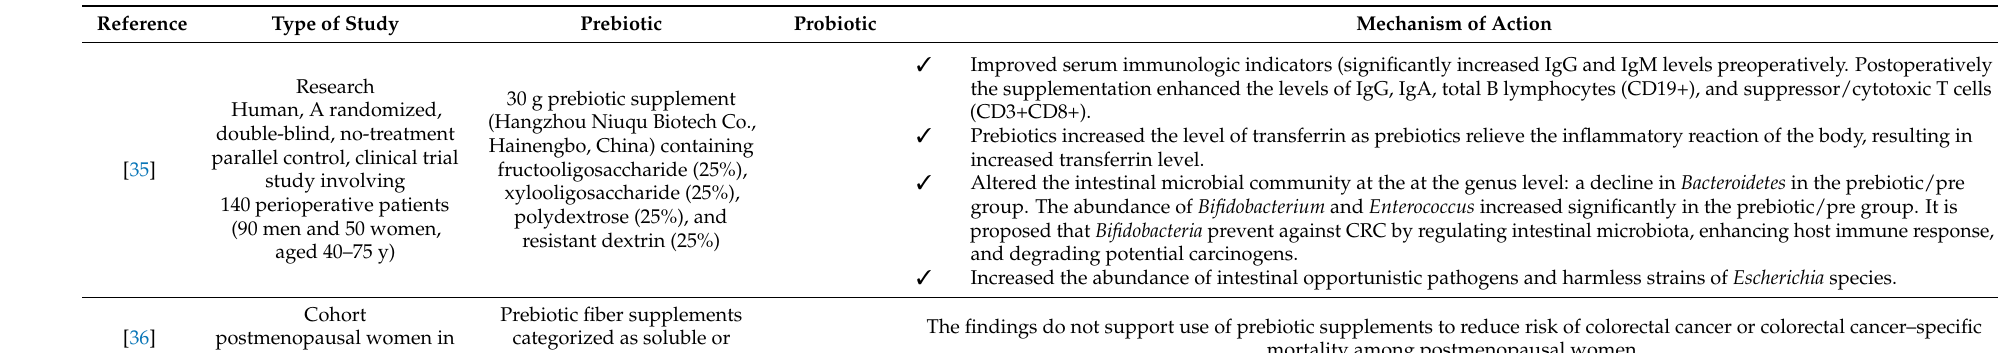
Table 4. Prevention of Colorectal cancer (CRC) Using Various Prebiotics in Human Clinical